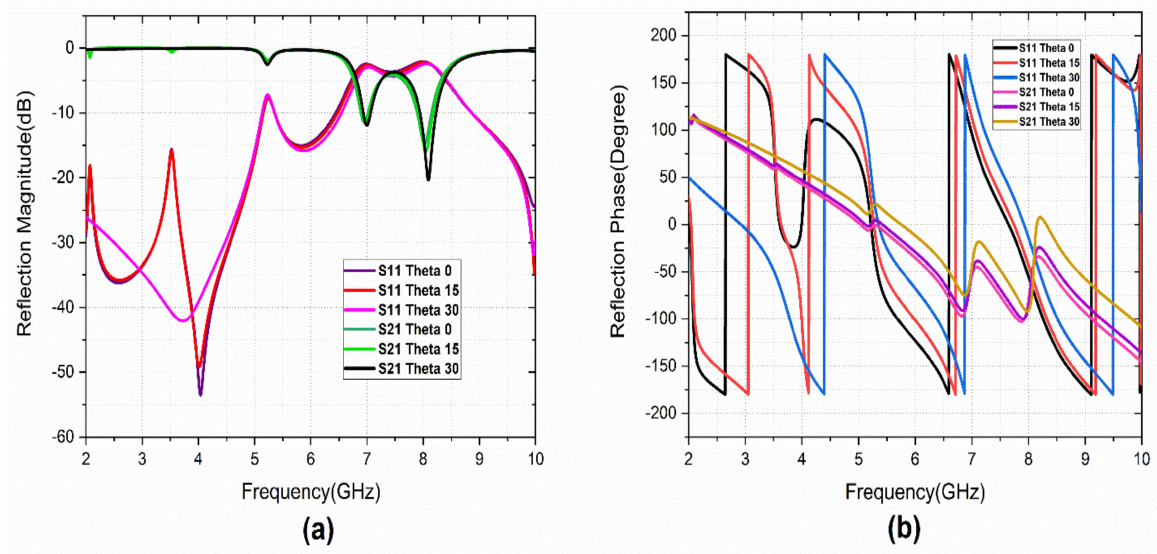
Figure 9. Reflection characteristics under TM incident angle variation: ( a ) magnitude ( b )